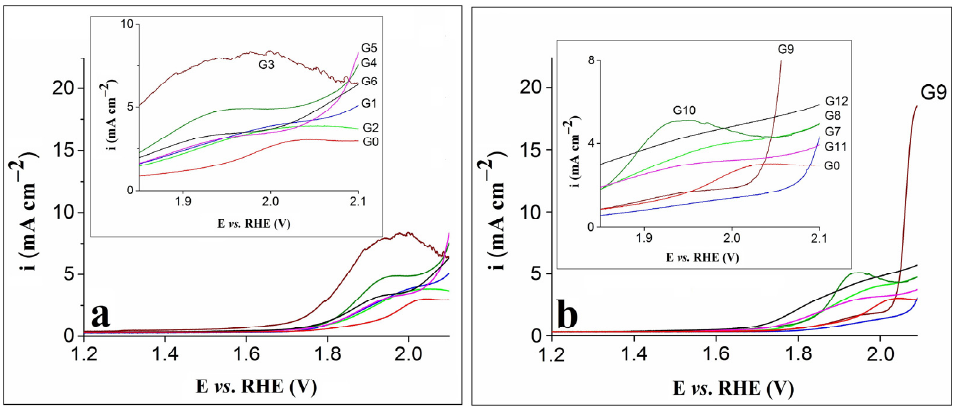
Figure 1. ( a ) LSVs recorded on the G0–G6 electrodes. ( b ) LSVs recorded on the G0 and G7–G12 electrodes. Insets in ( a ) and ( b ) correspond to enlarged regions of the LSVs.